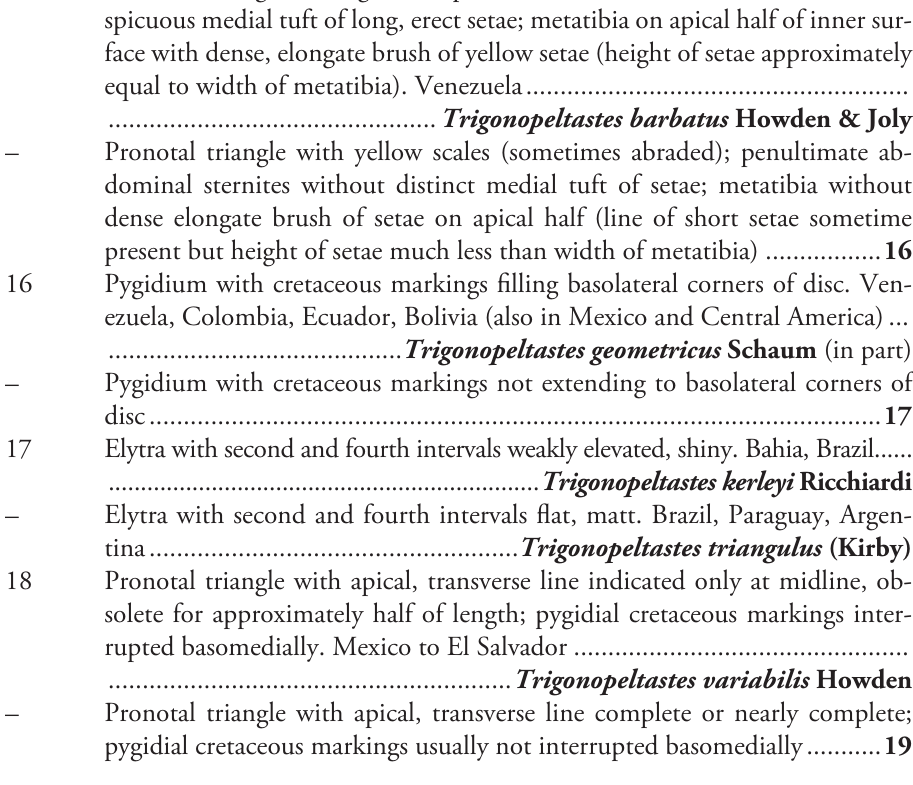
apically with a robust tooth. Mexico .... Trigonopeltastes deltoides (Newman)